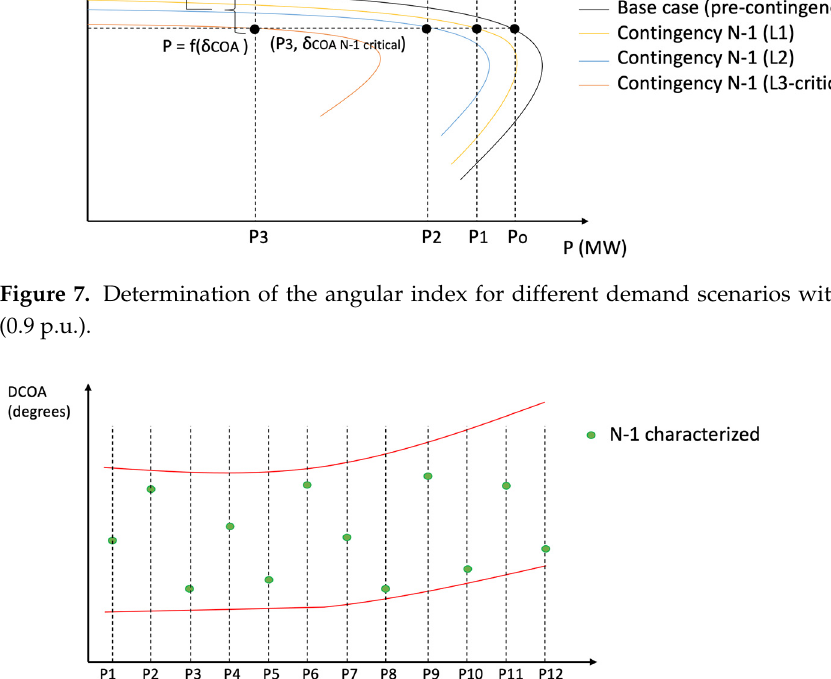
Table 1. Data of the operational areas in IEEE 39-bus system.